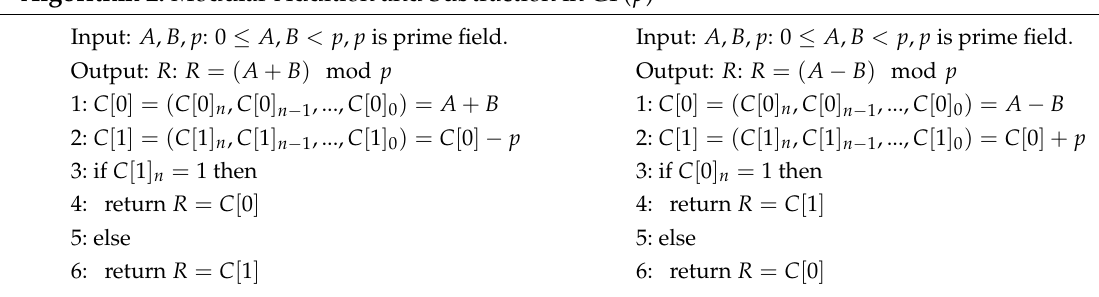
Algorithm 2: Modular Addition and Subtraction in GF( p )